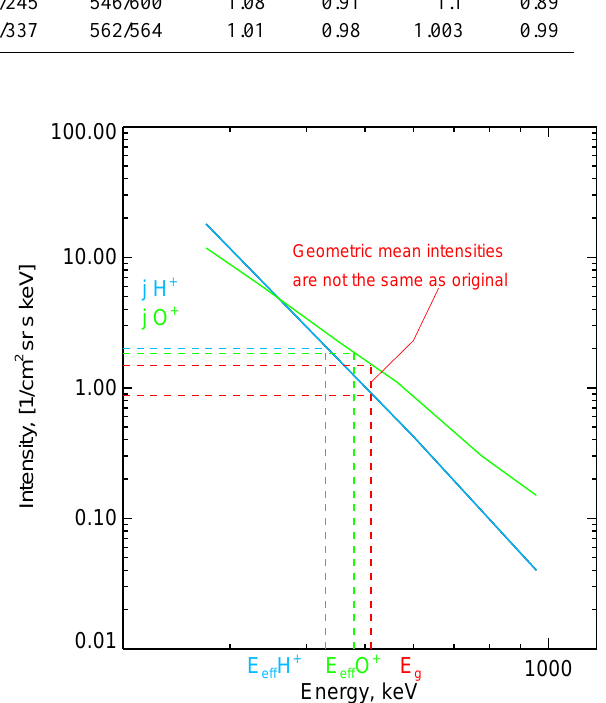
Fig. 1. Mean energy spectra (274–955keV) for the protons and oxygen for the time period from 11:30 to 24:00UT on 2 Septem- ber 2007, observed by Cluster, SC4. The effective energy, E g , based on geometric-mean assumption and its corresponding proton and oxygen intensities are denoted by red colour. There is a mismatch between original intensities and intensities which correspond to the geometric-mean effective